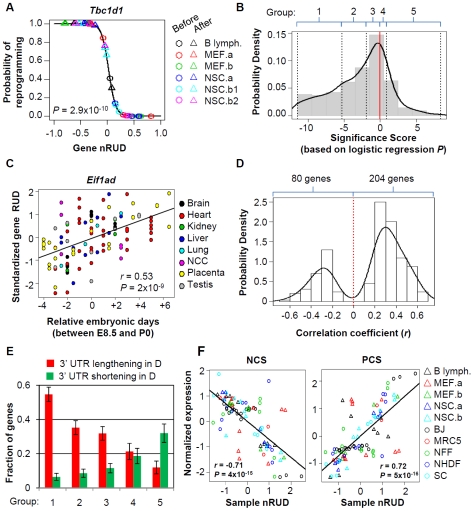
The 3′UTR regulation in generation of iPS cells is related to that in embryonic development.(A) An example of 3′UTR regulation in generation of mouse iPS cells. The gene Tbc1d1 was randomly selected. The relationship between reprogramming state, i.e. before and after reprogramming, and gene nRUD values from 6 different data sets for 3 different cell types was analyzed by logistic regression. Y-axis is predicted probability that a sample is iPS cell after fitting the logistic regression model. P-value for data fitting is shown in the graph. (B) Distribution of logistic regression significance score (SS) for all surveyed genes (674 in total) (See Methods for detail). As indicated on top of the graph, genes with negative SS were evenly divided into 3 groups and those with positive SS were divided into 2 groups. (C) An example of gene (Eif1ad) with 3′UTR lengthening in embryonic development. X-axis is relative embryonic days, with 0 being the median time point for each sample set. Y-axis is standardized RUD values which makes different sample sets comparable. Pearson correlation (r) and P-value for the linear regression line are shown in the graph, which reflect change of 3′UTR length over developmental time. (D) A total of 606 genes with APA that had detectable signals in more than 50% of all samples between 8.5 and P0 were surveyed, and 284 genes had significant change of 3′UTR over time (P<0.05). A histogram of correlation (r) for these genes is presented. (E) Comparison of 3′UTR regulation in generation of iPS cells and embryonic development. Genes with significant regulation of 3′UTRs by APA in embryonic development were shown in (D). Fractions of genes with lengthening (red) or shortening (green) 3′UTRs during embryonic development for each of the 5 groups derived from (B) are plotted. P-value (Chi-squared test comparing fractions of genes with 3′UTR lengthening in embryonic development in 5 groups with those with 3′UTR shortening) = 8.5×10−11. (F) Correlation between nRUD values in generation of iPS cells and mRNA expression of the genes that are negatively (left) and positively (right) correlated with 3′UTR length in embryonic development. These gene sets are called negative correlation set (NCS, 59 genes) and positive correlation set (PCS, 74 genes).